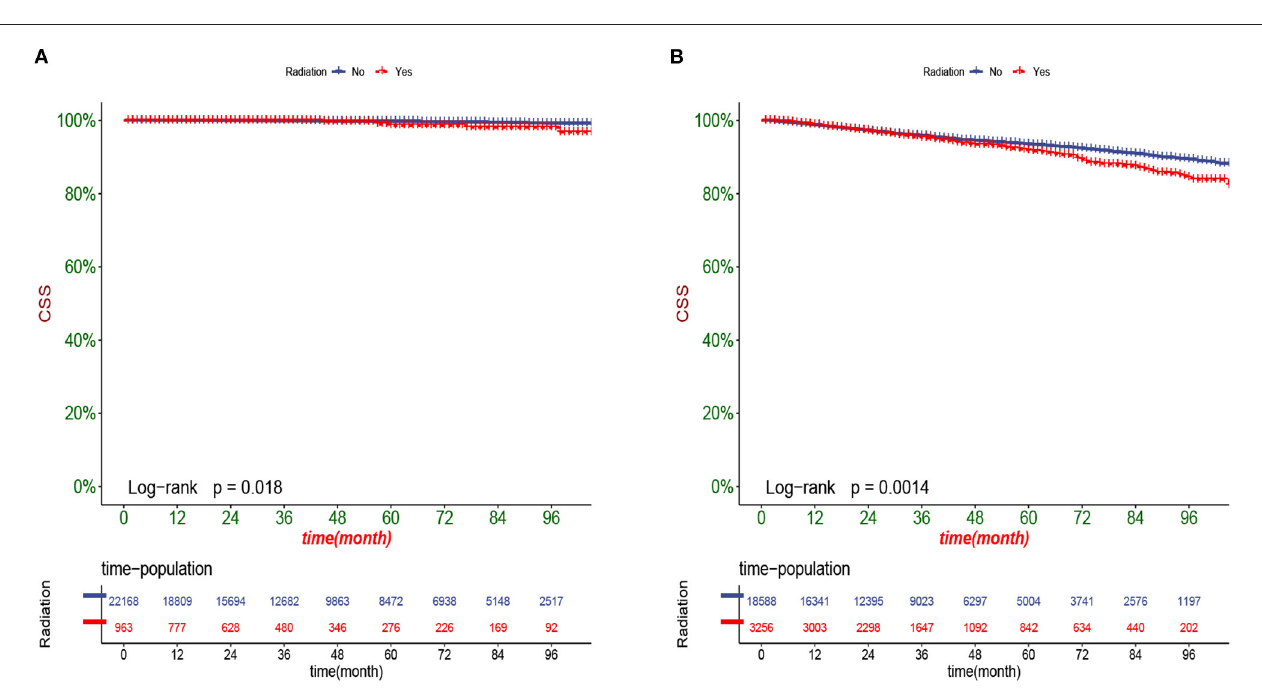
FIGURE 8 | Kaplan-Meier curves of patients with or without radiotherapy in the low-risk group (A) and high-risk group (B) .